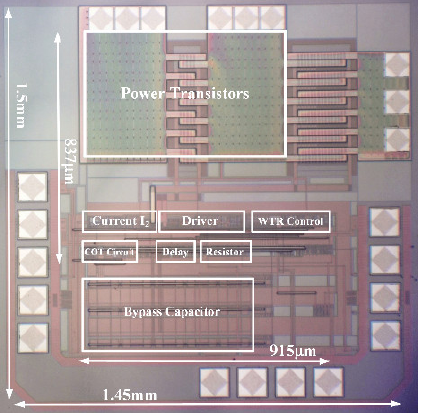
To verify the feasibility of WTR control and AOT circuit, a laboratory prototype of